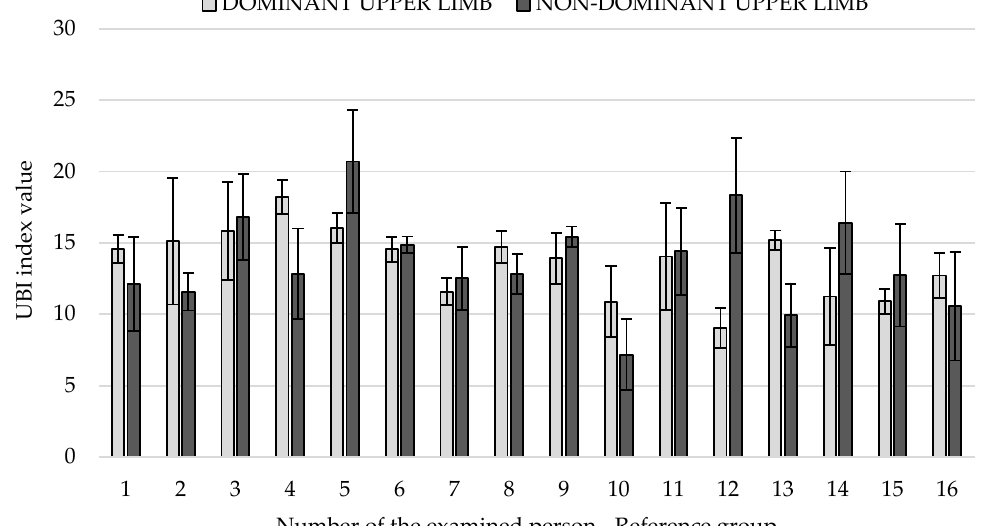
Figure 4. Values of the Upper Body Index indicator for the reference group.